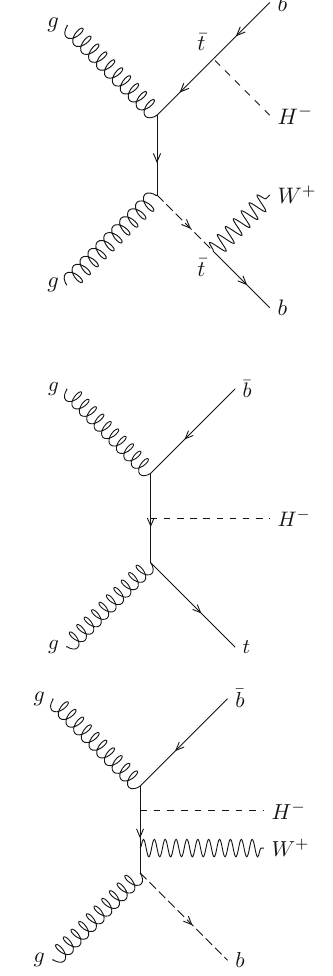
Fig. 1 Leading order (LO) diagrams for the charged Higgs particle are shown. The double-resonant top pair production (top diagram) is the dominant process for light H ± . The single-resonant top quark pro- duction(middlediagram)isdominantforheavy H ± .Intheintermediate H ± scenario ( M H ± ∼ M t ), both of these production channels along with the non-resonant top quark production (bottom diagram) are taken into account with the single-resonant and double-resonant modes.